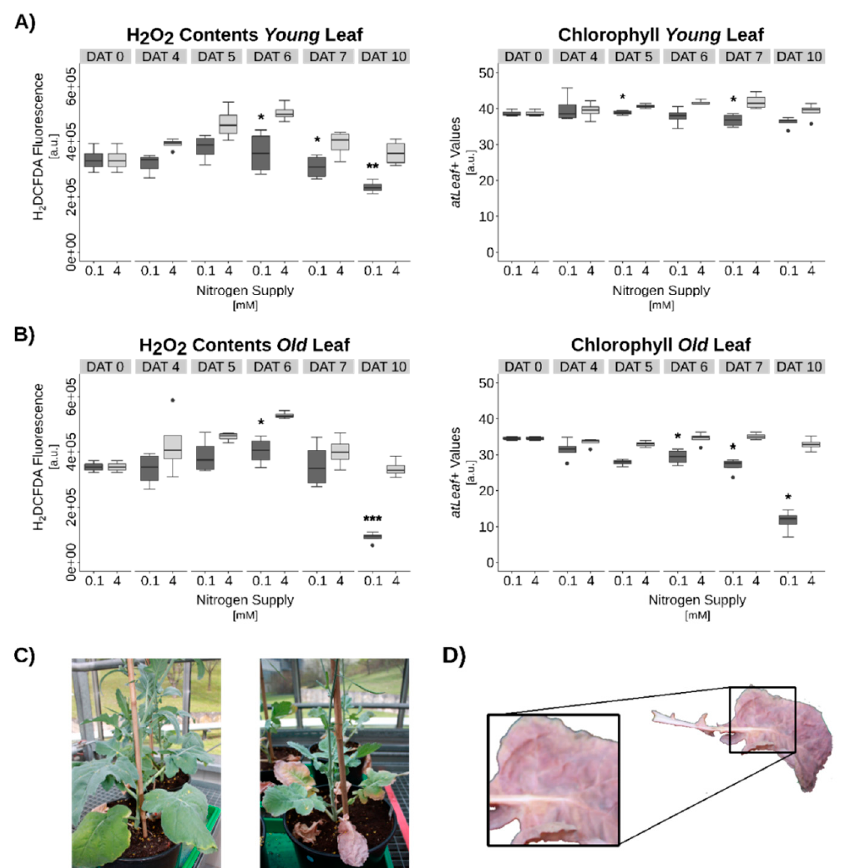
Figure 5. Nitrogen (N) starvation induced senescence in Brassica napus . ( A ) and ( B ) Hydrogen peroxide (H 2 O 2 ) and chlorophyll contents in young leaves ( A ) and in old leaves ( B ). ( C ) Plant grown under full N-supply (left) and under N-starvation (right). ( D ) Exemplary anthocyanin accumulation pattern in N-starved plants. Statistics: Welch’s t-test. Significance levels: p < 0.001 = ***; p < 0.01 = **; p < 0.05 = *. Data are medians +/ − 1.5xIQR of at least 3 biological and 2 technical replicates each.